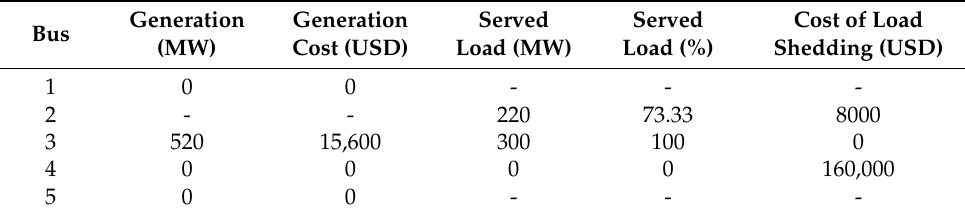
Table 6. Description of served loads and load shedding costs.